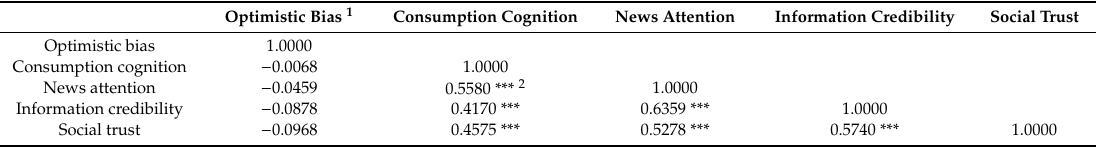
Table 4. Correlation coefficients between variables in the mainland China model.